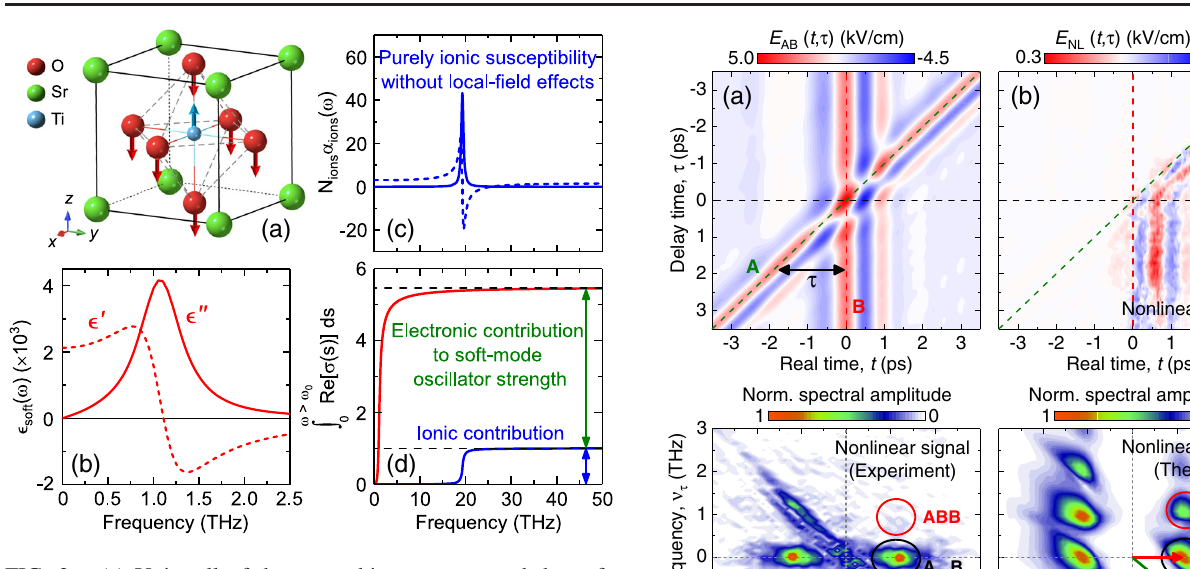
FIG. 3. (a) Unit cell of the perovskite structure and the soft- mode oscillation in SrTiO 3 . (b) Real and imaginary parts of the soft-mode dielectric function modeled with a damped harmonic oscillator having a Lorentzian profile. (c) Real and imaginary parts of the purely ionic susceptibility excluding any local-field effects. (d) Integral of the real part of the conductivities corresponding to the electronic and ionic oscillators. With the double arrows at 47 THz, we read the values of the oscillator strengths (black-dashed lines) well above both the soft-mode resonance and the resonance from the purely ionic susceptibility.